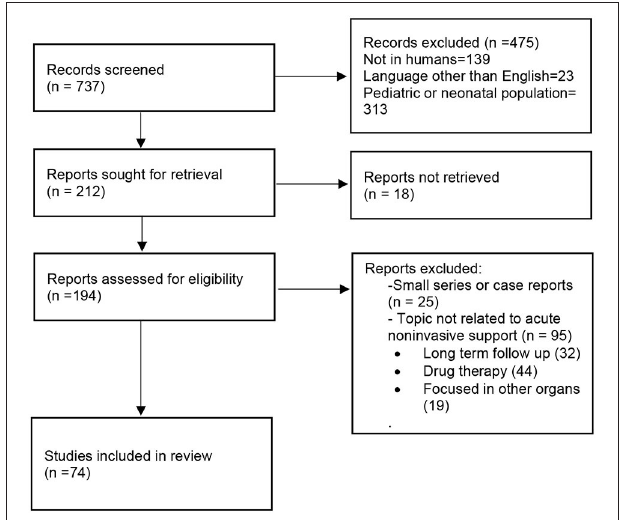
FIGURE 1 | PRISMA-based flowchart for the selection of